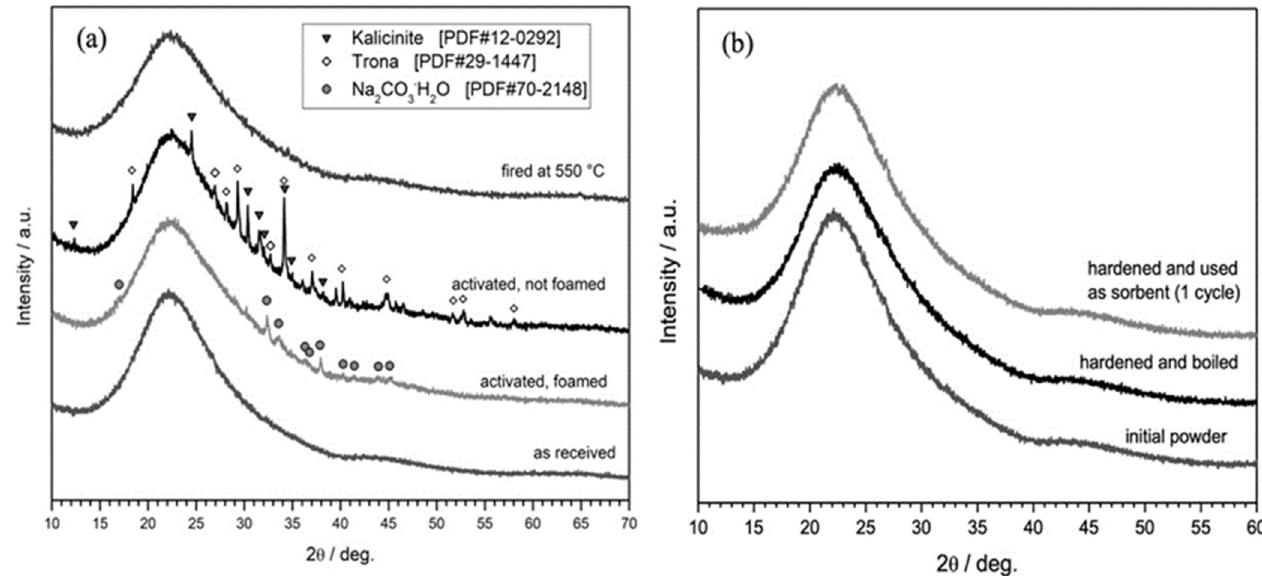
Figure 4. X-ray diffraction patterns of boro-alumino-silicate glass ( a ) in the as-received state, after activation and after firing; ( b ) after boiling and use as sorbent.